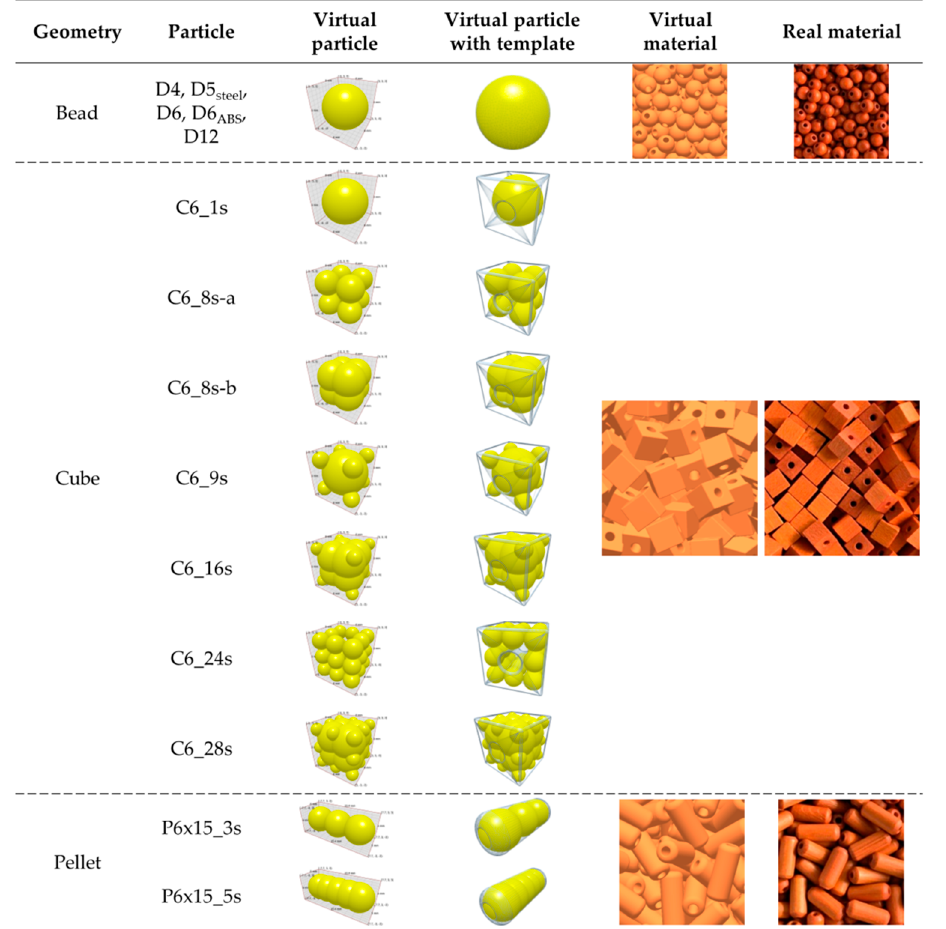
Figure 2. Overview of created virtual particles.